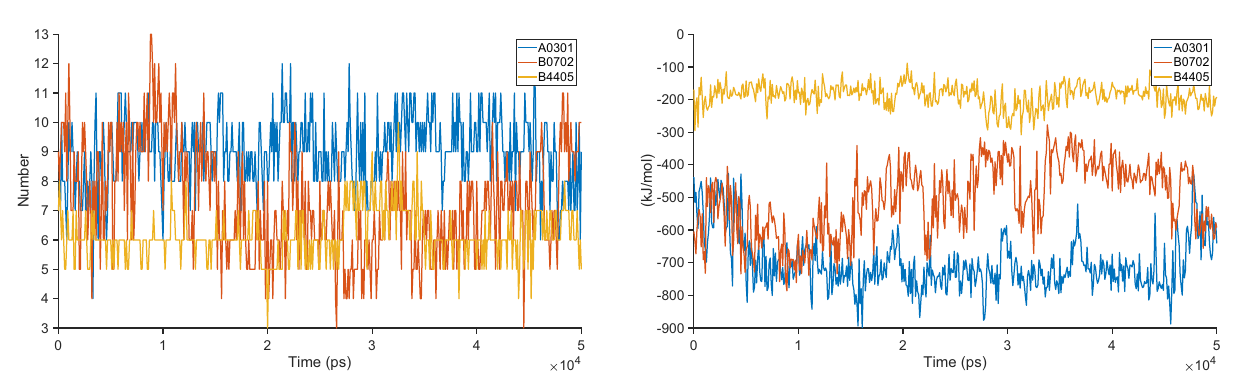
Figure 7. The interaction plots. Hydrogen bonds (left), short-range coulombic interactions